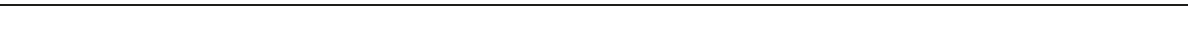
Fig. 2 Prediction error in representative examples of neuronal responses in anaesthetized rat. a Examples of lemniscal neuronal responses in each recorded auditory station (columns). The fi rst row contains schematics of the lemniscal subdivisions (green) within each nuclei. The second row shows the frequency-response area (representation of neuronal sensitivity to different frequency-intensity combinations) of representative lemniscal neurons from each nucleus. Ten grey dots within each frequency-response area represent the ten tones (f i ) selected to build the experimental sequences (see Methods). The third row displays the measured responses of the particular neuron to each f i tone (baseline-corrected spike counts, averaged within 0 – 180 ms after tone onset) for all conditions tested. Note that measured conditions tend to overlap in the subcortical stations (IC L and MGB L ), and only start differentiating from each other once auditory information reaches the cortex (AC L ). The fourth row contains sample peri-stimulus histograms comparing the neuronal responses to each condition tested for an indicated f i tone. A thick horizontal line represents stimulus duration. A small inset within the upper right corner of each panel features the isolated spike (mean ± SEM) of that single neuron. b Examples of non-lemniscal neuronal responses in each recorded auditory nuclei, organized as in a . The fi rst row highlights non-lemniscal divisions in purple. In the second row, note frequency-response areas tend to be more broadly tuned, as compared to lemniscal neurons. In the third row, responses to deviant conditions tend to relatively increase and distance themselves from their corresponding controls as information ascends in the auditory pathway. Also note that responses to last standards are feeble or even completely missing across all non-lemniscal stations (IC NL , MGB NL and AC NL ). In the last row, the strong in fl uence of the experimental condition over